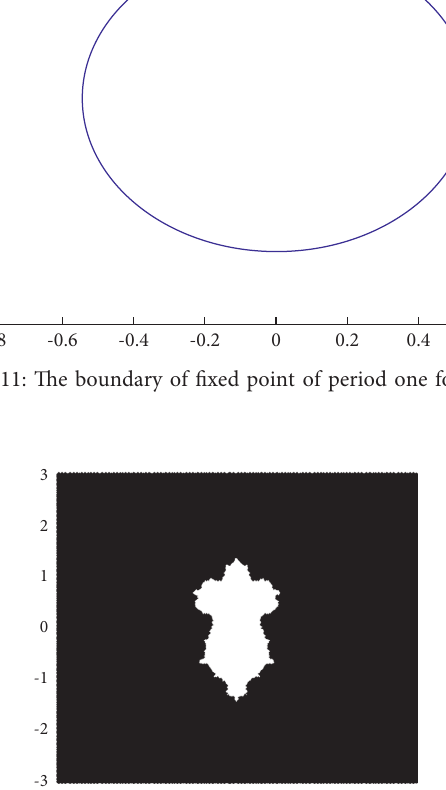
( z ) � z 3 + z + c is connected where 3